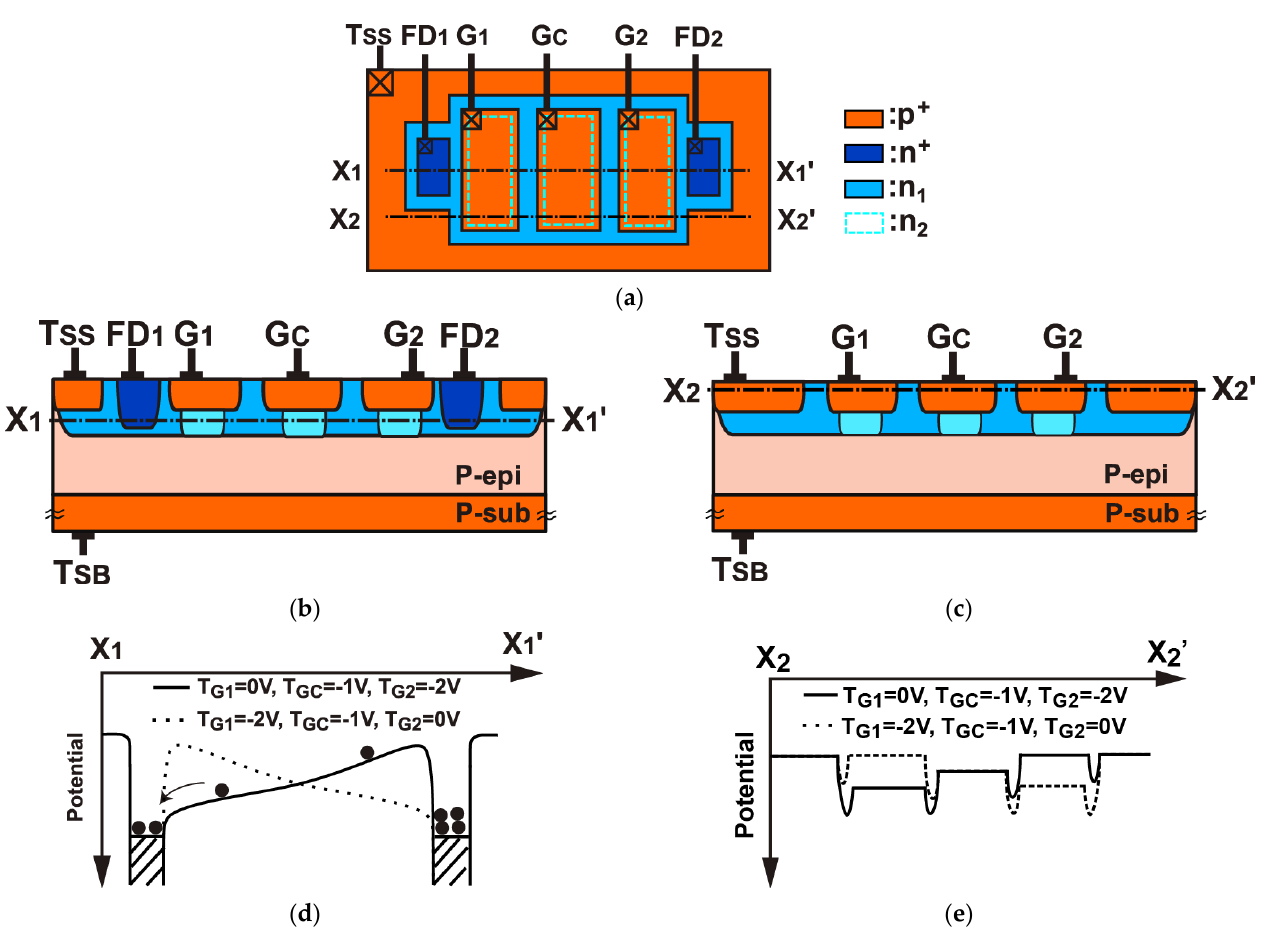
Figure 1. Structure and principle of the two-tap p-n junction demodulator (PND): ( a ) Top view; ( b ) Cross-sectional view (X 1 –X 1 ’); ( c ) Cross-sectional view (X 2 –X 2 ’); ( d ) Potential diagram at the channel (X 1 –X 1 ’); ( e ) Potential diagram at Si surface (X 2 –X 2 ’).